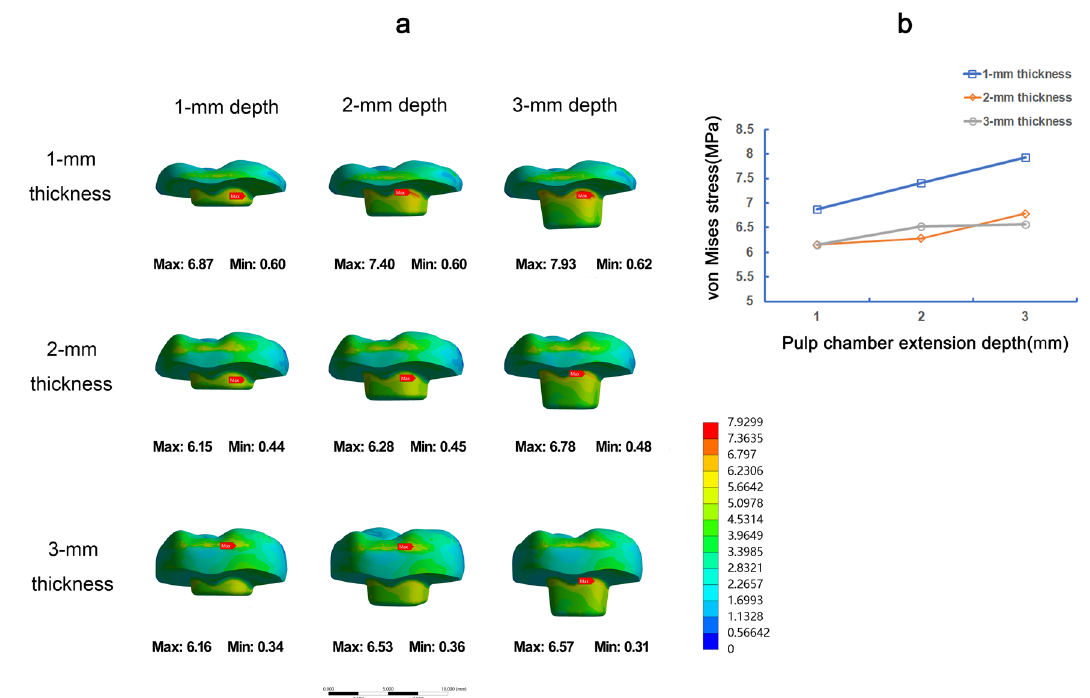
Fig. 3 The von Mises stress (MPa) distribution on endocrown restorations in 9 FEA models under vertical load. Stress distribution plots of nine endocrown restorations with 1-mm, 2-mm, or 3-mm pulp chamber extension depth in combination with 1-mm, 2-mm, or 3-mm